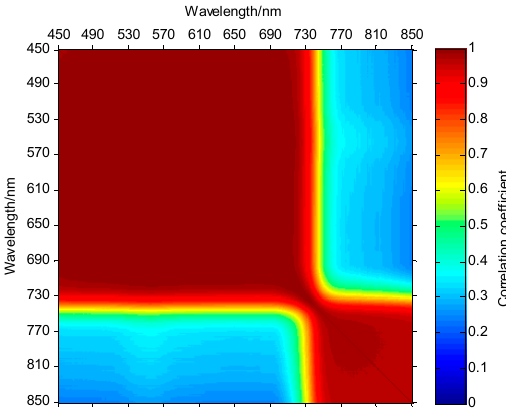
Figure 3. Correlation coefficient diagram.